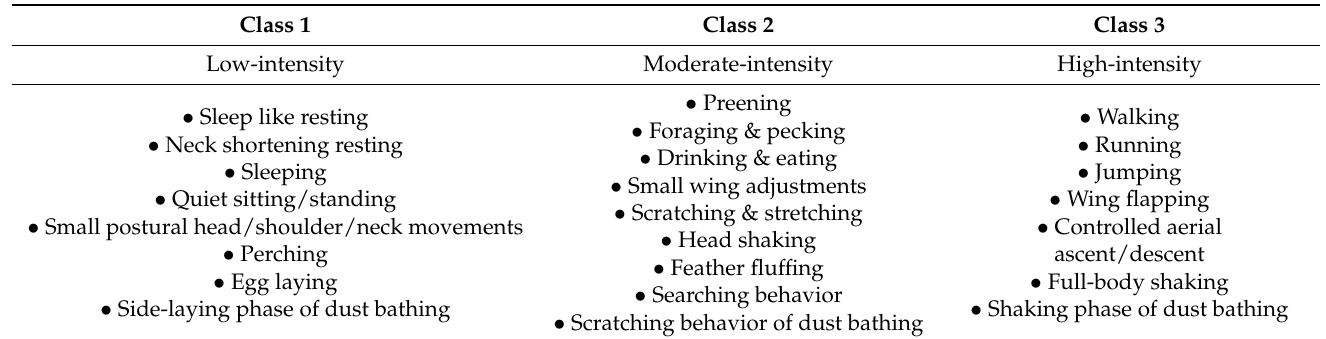
Table 2. Classification of physical activity of laying hens based on their intensity (adopted and modified from Table 2 in ref